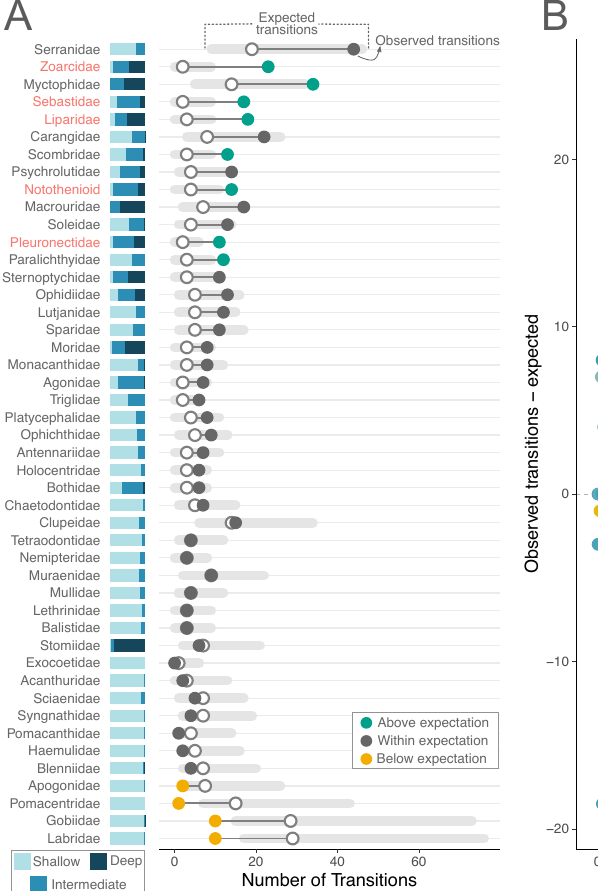
transitions averaged across 100 stochastic character maps. B The relationship between transitions across depth regions (observed transitions minus the median expected number of transitions) and median latitude. Each point depicts a clade and points are colored by family-speci fi c speciation rate, as estimated from Rabosky et al. 9 Source data are provided as a Source Data fi